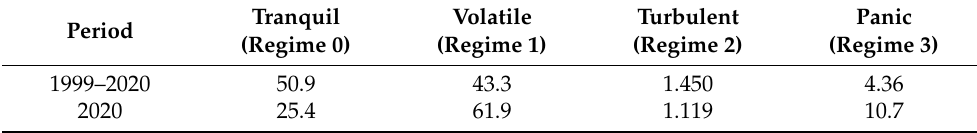
Table 13. Percentage of time spent by the RTSI index in each